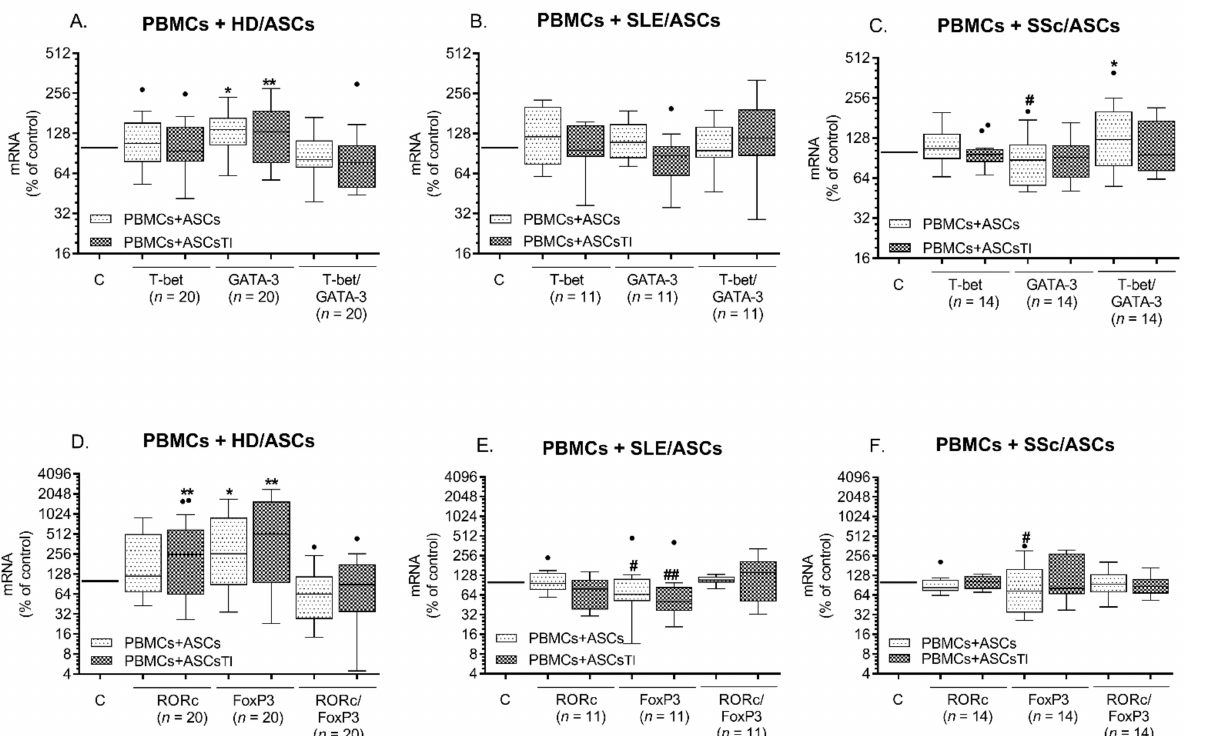
Figure 1. Direct effects of ASCs on the expression of Th subset-specific transcription factors in activated T cells. T helper (CD3 + CD4 + ) lymphocytes (T) were isolated from peripheral blood of 22 healthy volunteers, activated via CD3/CD28 pathway, and co-cultured for 5 days with either untreated or TNF + IFN γ (TI) pre-stimulated ASCs lines from healthy donors (HD/ASCs, A , D ), SLE (SLE/ASCs, B , E ), or SSc (SSc/ASCs, C , F ) patients. The co-cultures were done using a random combination of both cell types, and the number of experiments performed is shown (n). The levels of expression of mRNAs encoding transcription factors specific for Th1, Th2, Th17, and Treg subsets (T-bet, GATA3, RORc, and FoxP3, respectively) were assessed by quantitative RT-PCR, as described in the Materials and methods. Results are expressed as the percentage of the mRNAs expression levels regarding those found in separately cultured control activated T cells and are shown as the Tukey’s boxes with the median (horizontal line), interquartile range (IQR, box), lower and upper whiskers (data within 3/2xIQR), and outliers (points/dots). One-way analysis of variance (ANOVA) with repeated measures and post-hoc Tukey test was used to evaluate the effect of ASCs (T vs. T + ASCs or ASCs TI ; * p = 0.05–0.01; ** p = 0.01–0.001; *** p = 0.001–0.0001). The inter-group (HD vs. SLE vs. SSc) comparison was performed using the Kruskal-Wallis and Dunn’s multiple comparison test (# p = 0.05–0.01; ## p = 0.01–0.001; ### p = 0.001–0.0001 for the groups of patients vs. HD comparison).